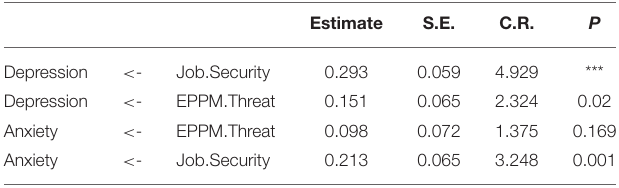
TABLE 4 | Standardized parameter estimates, standard errors, and p -values for the structural